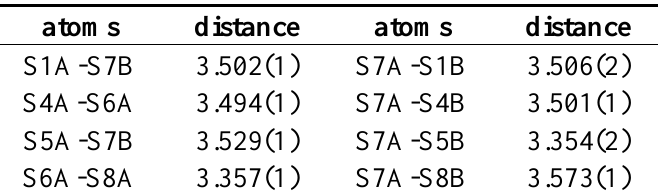
CH Cl) ( 5 2 2 0.5